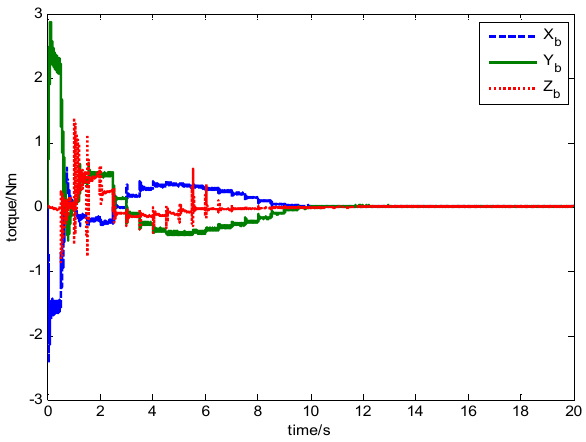
Figure 29. Torque calculated using Equation